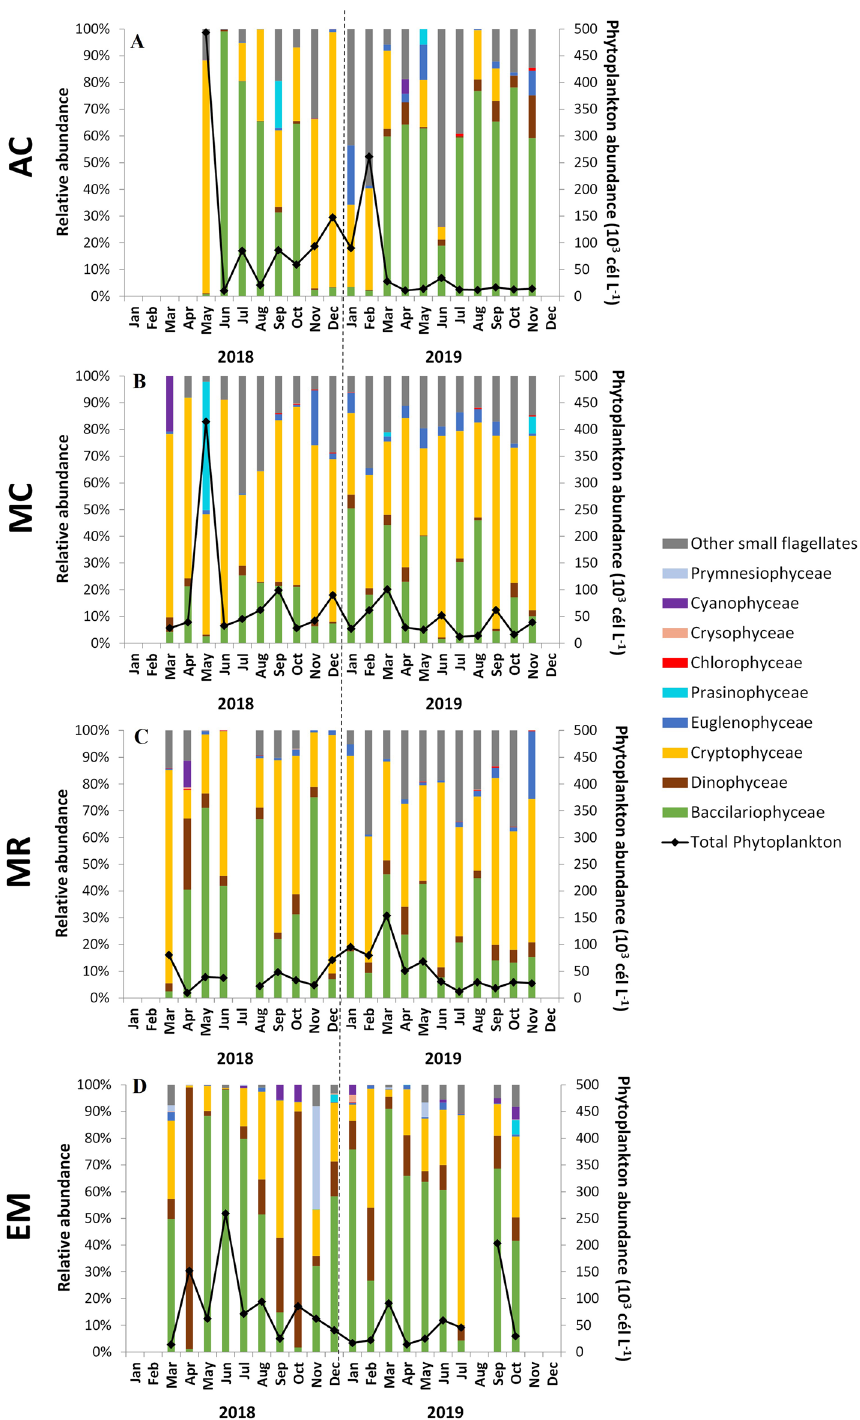
Figure 6. Relative abundance of different phytoplankton groups (colored bars) and phytoplankton cell abundance (× 10 3 cell L −1 ) (dots with connecting line) obtained for each sampling month in the different study sites: ( A )—AC, ( B )—MC, ( C )—MR and ( D )—EM. No data available in July 2018 at MR and in August 2019 at EM. See the legend figure for the phytoplankton groups